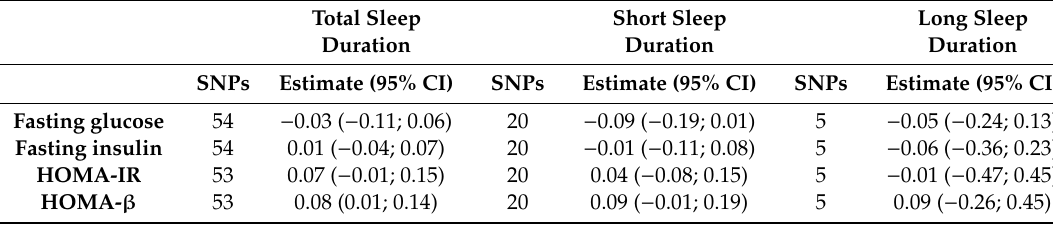
Table 2. Inverse-variance weighted estimates for sleep duration on glycemic